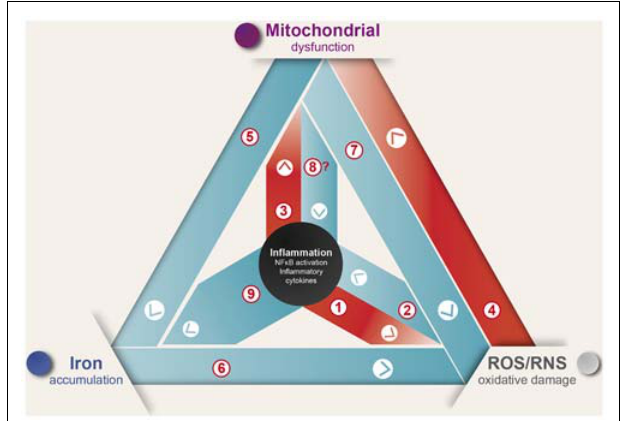
FIGURE 1 | Inflammation causes ROS/RNS production, mitochondrial dysfunction, and iron accumulation. Inflammation, oxidative damage, and mitochondrial dysfunction are common features of neurodegenerative diseases. A complex net of relationships connect these features, which through feedback mechanisms contribute to the evolvement of neuronal death (see text for